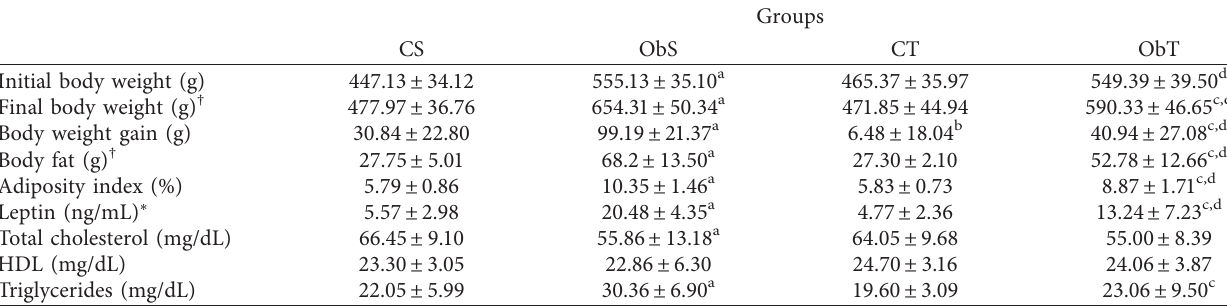
Table 2: Adiposity, comorbidities, and hormonal parameters.